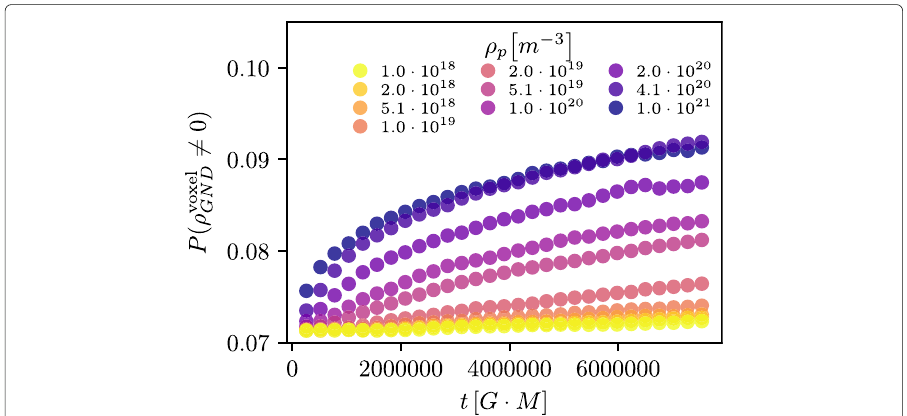
Fig. 8 The probability of finding the GND density inside a voxel to be non-zero during the simulations. The results averaged over systems with specific ρ p . The number of voxels used here was 25 × 25 × 25, but similar observations were made with other number of voxels as